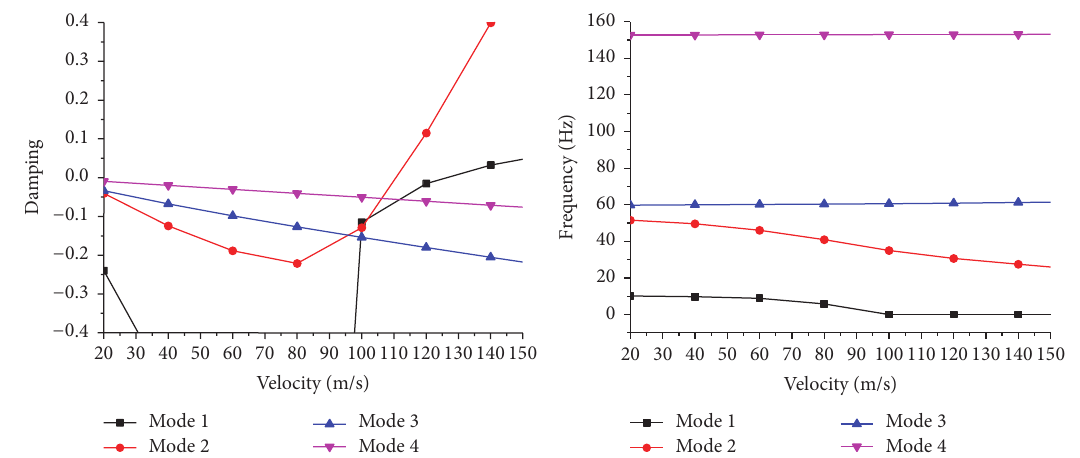
Figure 4: 𝑉 - 𝑔 and V - 𝑓 curves of quasi-isotropic panel (𝑉 1 = 𝑉 2 = 𝑉 3 = 0) .